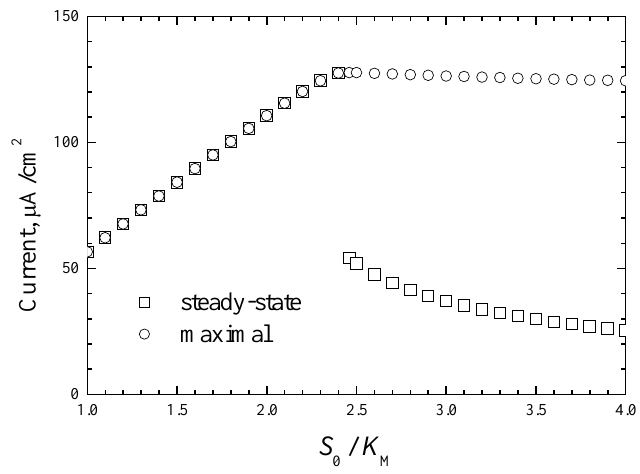
/ K values, V = 10 mM/s, d = 10 µ m. 0 M max